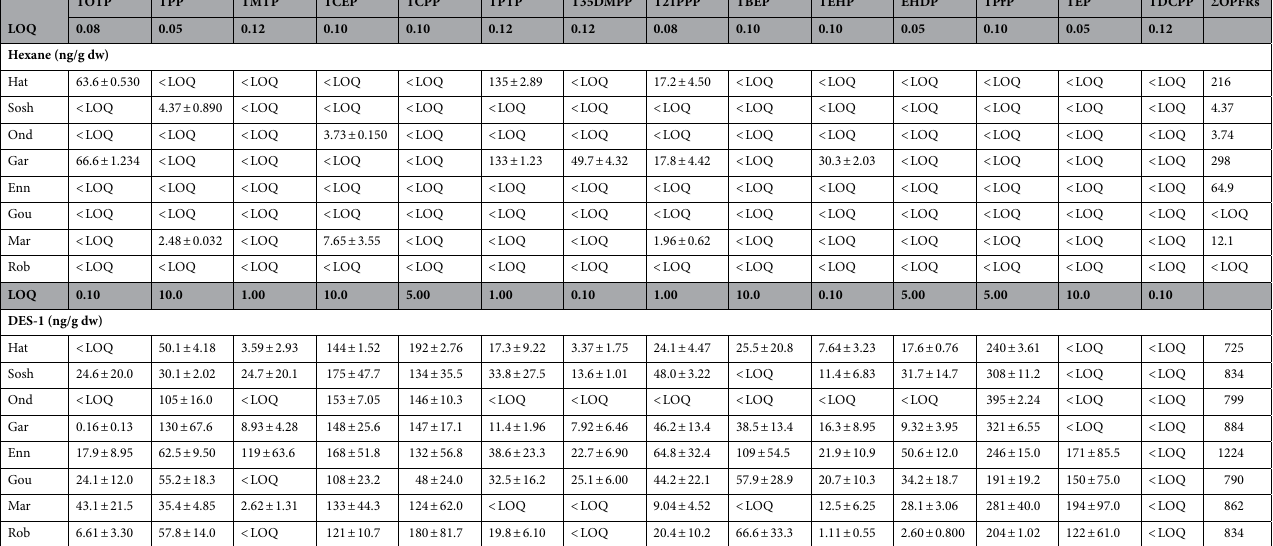
Table 6. Mean (n = 2) OPFR concentrations ± SD in sediment (ng/g dw) from eight selected landfill sites extracted using hexane and DES-1. Ond = Onderstepoort, Gar = Ga-Rankuwa, Sosh =